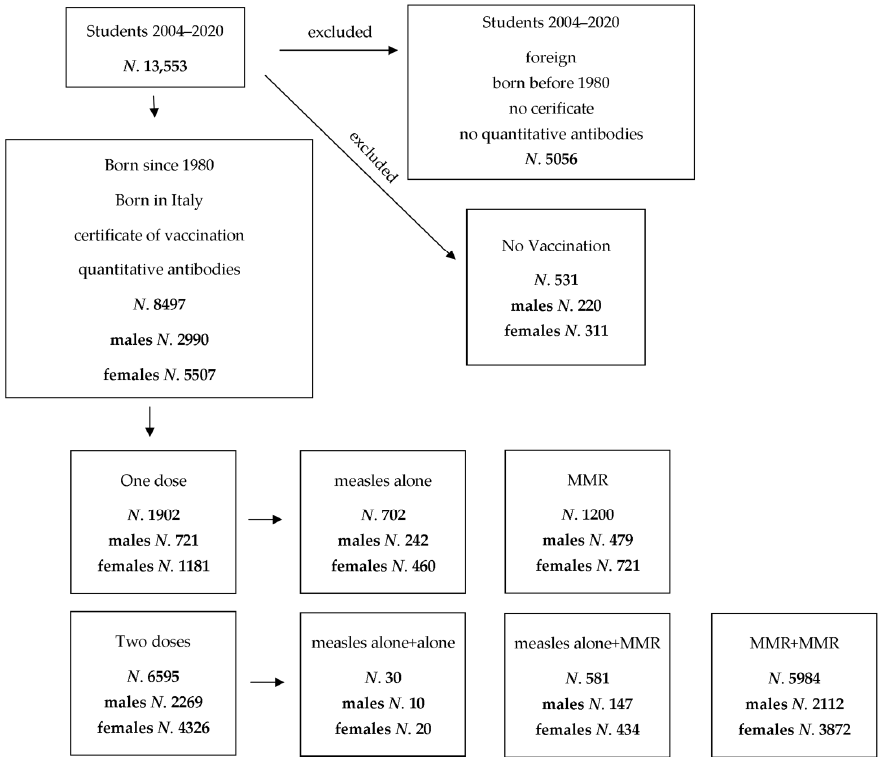
Figure 1. Criteria adopted to enroll students in the study. Only vaccinated students, born in Italy, who presented a vaccine certificate released by the Public Health Office and with quantitative measurement of measles antibodies were enrolled.